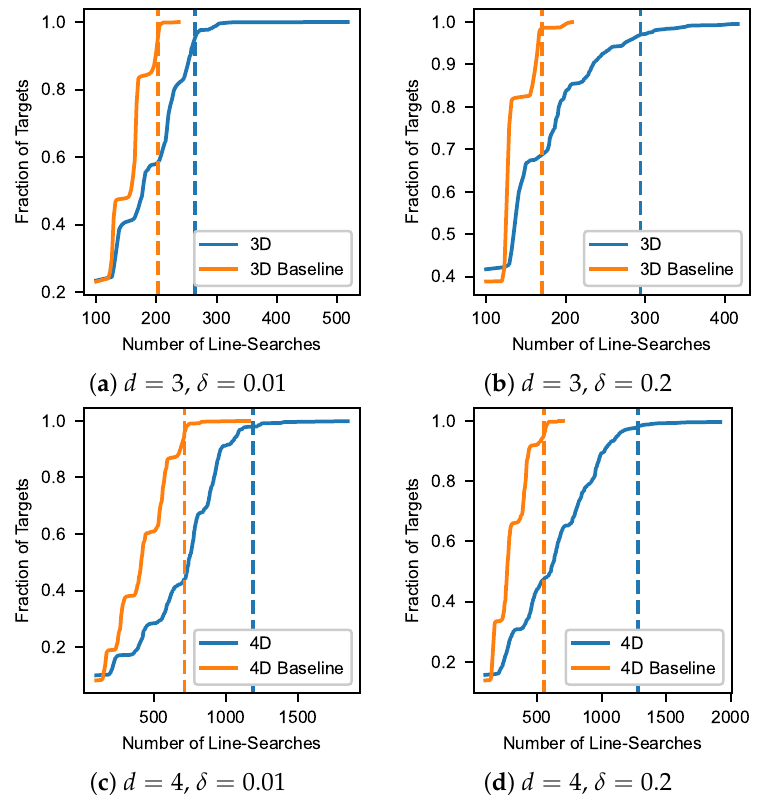
Figure 5. Estimated cumulative distribution function (ECDF) depicting the fraction of reached precision targets over number of line searches for the simulated device. For each run there are 20 reachable targets, geometrically spaced between (cid:101) end = 1.5 · δ and 10. Let X i be the training set used to train model ˆ P i in the i -th iteration of Algorithm 1. The j th target t j is considered reached if we find an i such, that max x ∈ X dist ( ∂ ˆ P i , x ) < t j . The | X i | for the smallest i fulfilling this is used as i + 1 the number of line searches required. Vertical dashed lines represent the point where 75% of runs are